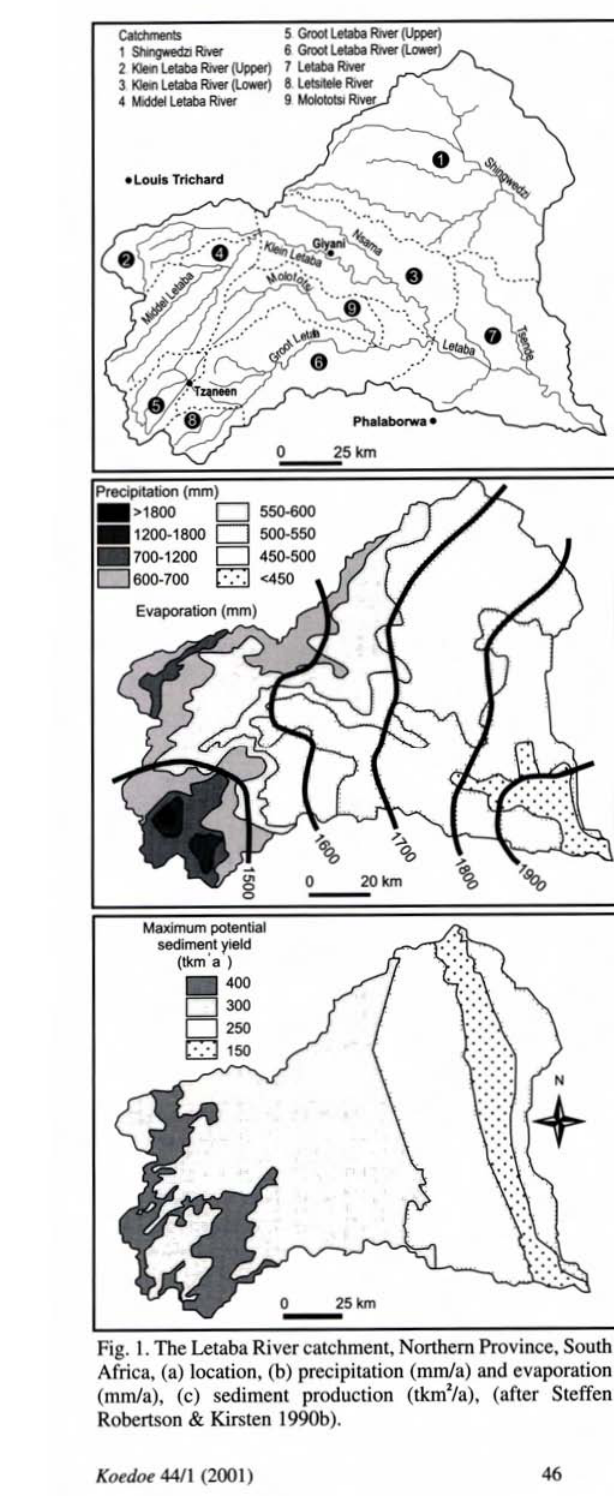
Fig. I. The Letaba. River catchment. Nonhern Province. South Africa. (a) location. (b) precipitation (mmla) and evaporation (mmla). (c) sediment production (tkm"a). (after StelTen Robertson & Kirsten